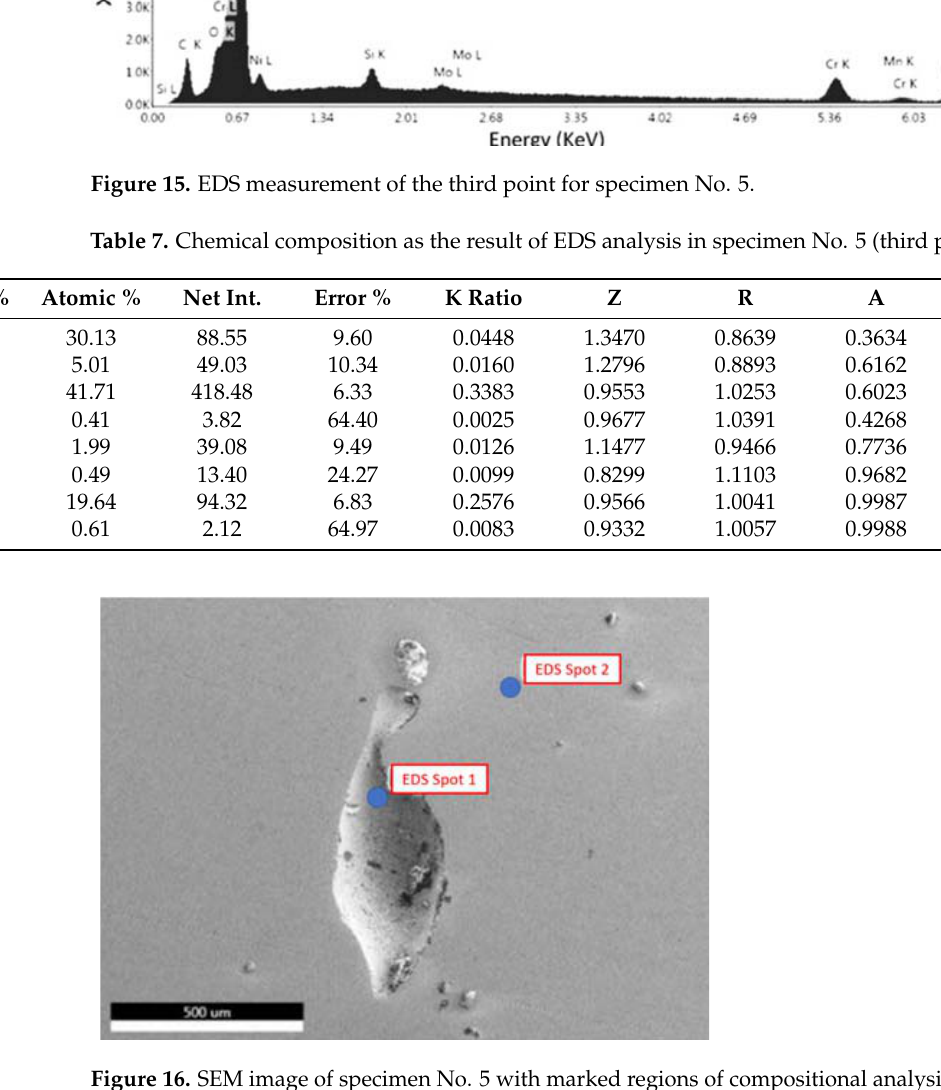
Figure 17. EDS measurement of the first point for specimen No. 5 to study the lack of fusion de- fect. Table 8. Chemical composition as the result of EDS analysis in specimen No. 5 (first point) to study the lack of fusion defect. Element Weight % Atomic % Net Int. Error % K Ratio